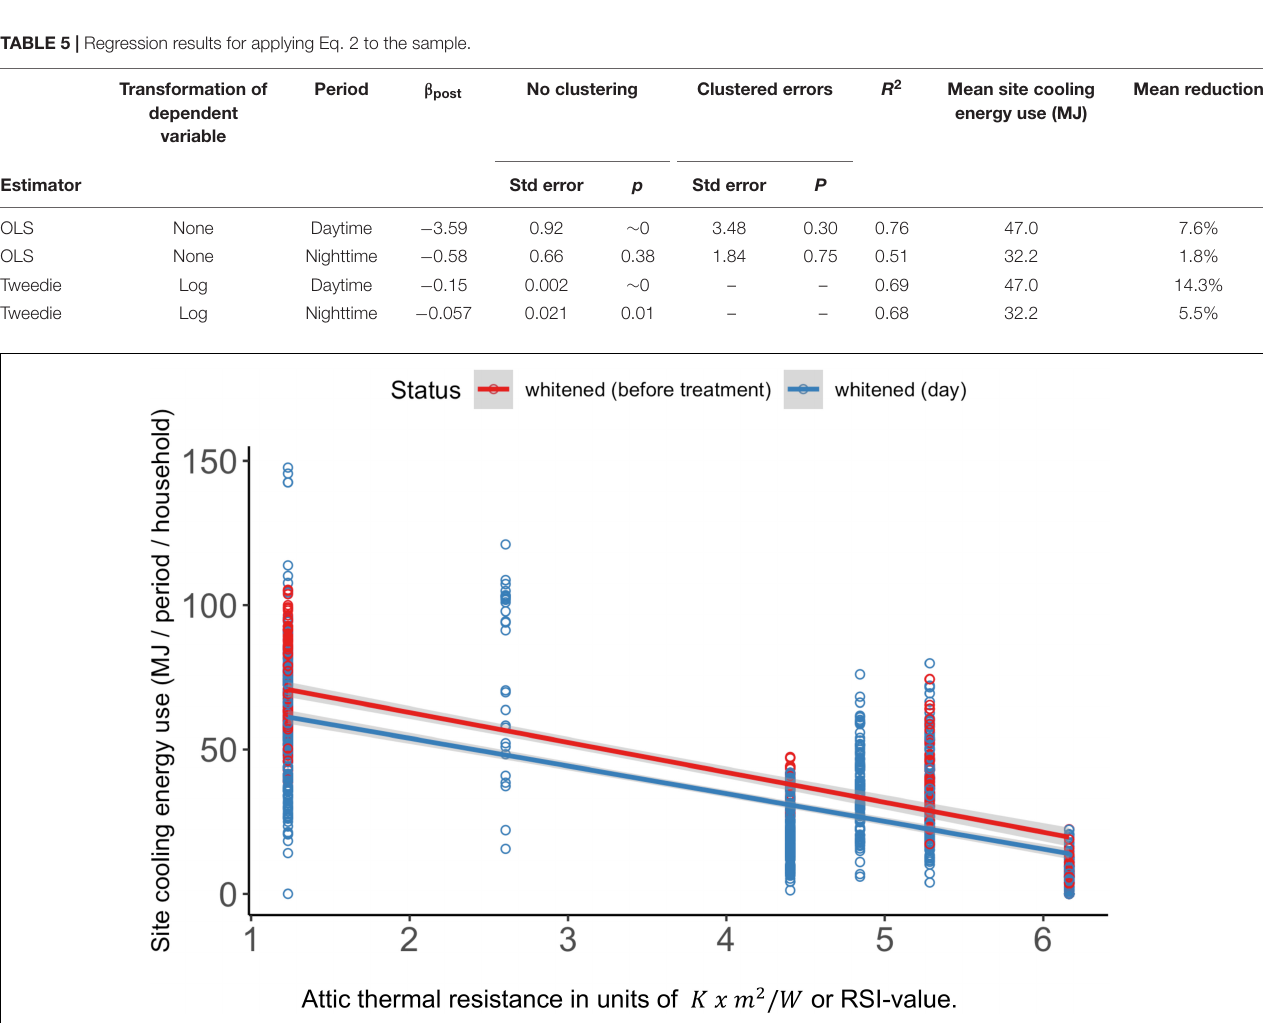
FIGURE 2 | Household-level variation in site cooling energy use given attic insulation and whitening for six treated household. Attic insulation is not reported for one of the seven treated households. Convert the RSI value to an R value (in ◦ F · ft 2 · h/BTU) by multiplying RSI values by 5.68.